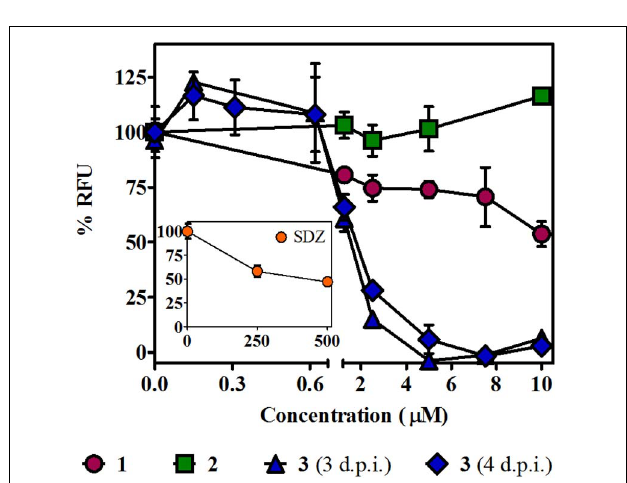
FIGURE 3 | Effects of 1 – 3 (7.5 µ M) and SDZ (500 µ M) on tachyzoite cell cycle distribution. Results are expressed as the mean percentages of tachyzoites in G1 (black) or S/M (white) phases ± SEM. Hash symbols indicate significant differences between drug treatments and controls, according to ANOVA/Dunnett’s tests ( p < 0.05).